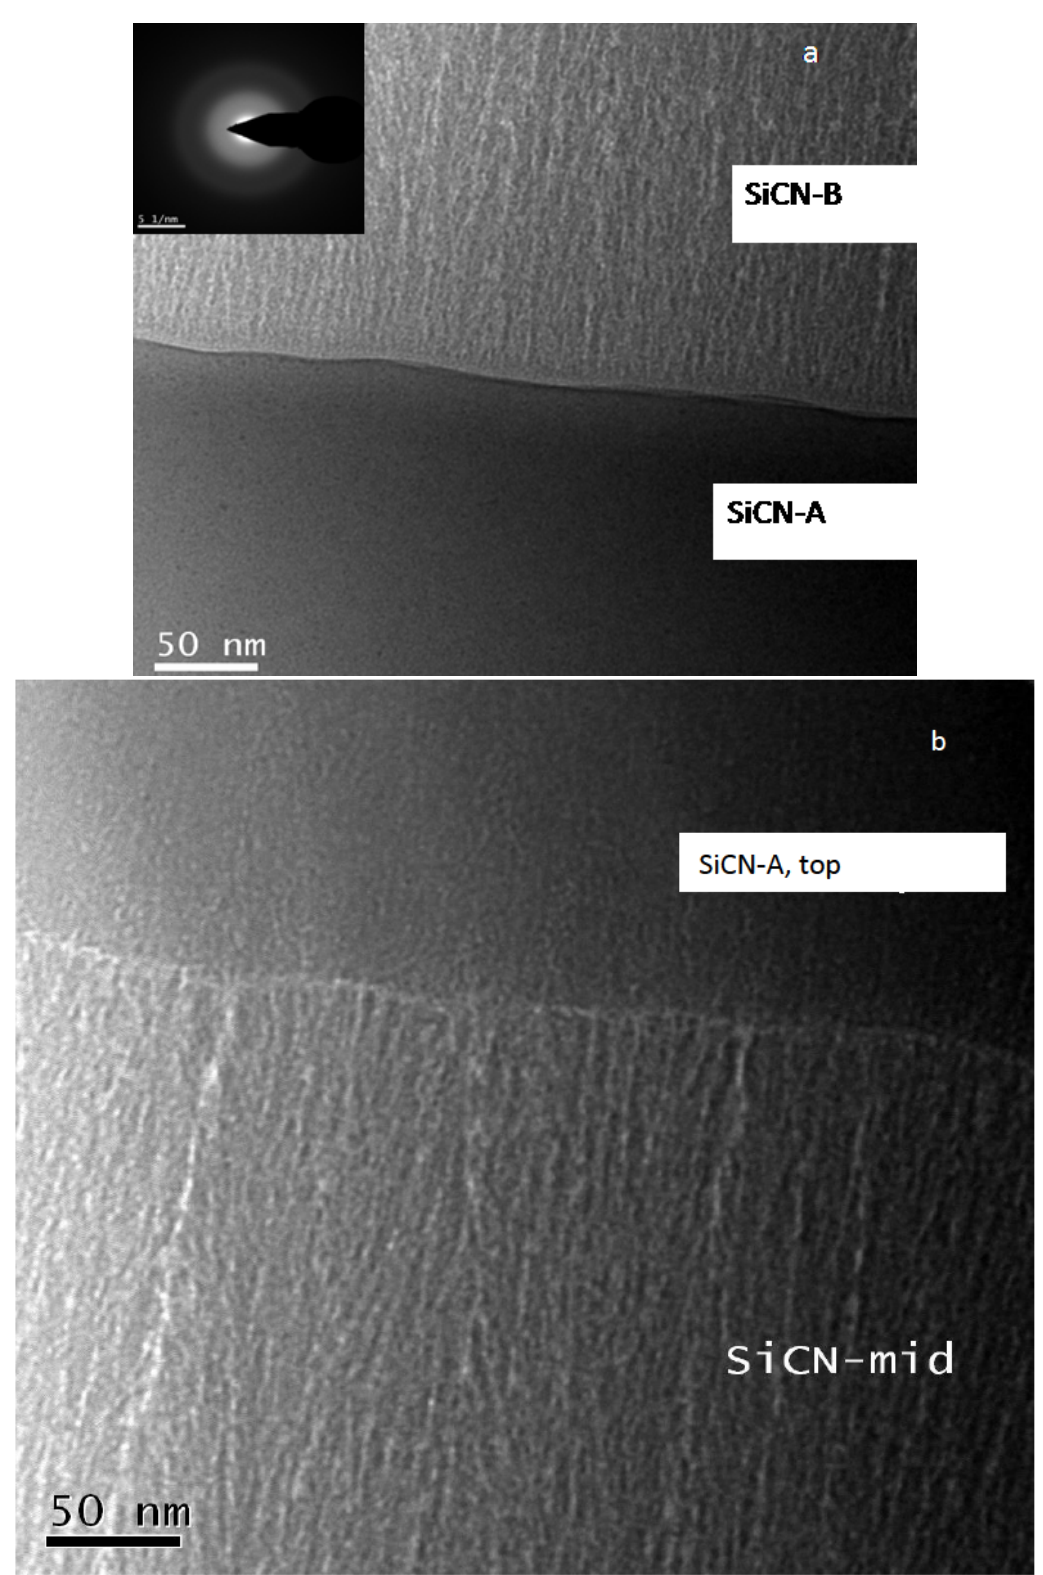
Figure 15: Cross section TEM microstructure and interface of SiCN coating at different interfaces of trilayer hard-soft-hard sequence